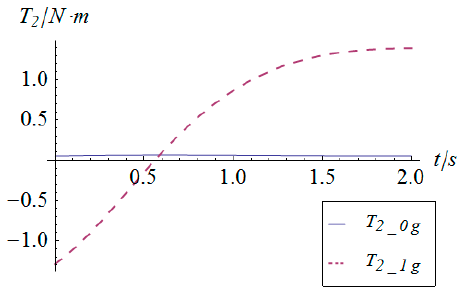
Figure 10. Driving torque vs. time of actuator 1.